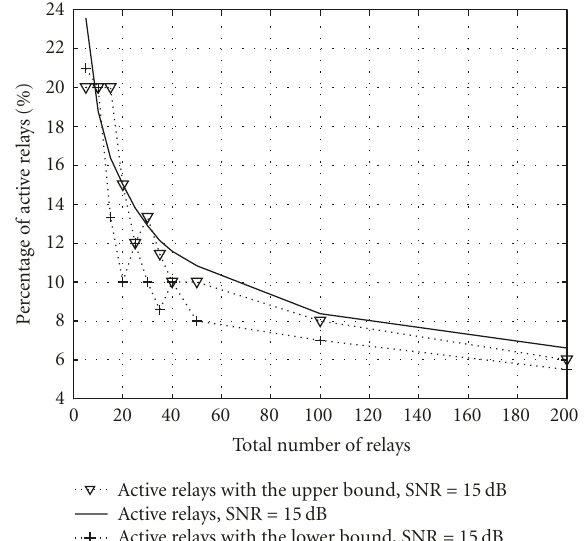
Active relays with the upper bound, SNR = 15dB Active relays, SNR = 15dB Active relays with the lower bound, SNR = 15dB Figure 8: Expected number of active relays (in %) of a multiple relay channel with transmit SNR = 15dB, under Rayleigh fading. The number of relays that optimizes the upper and lower bounds are shown for